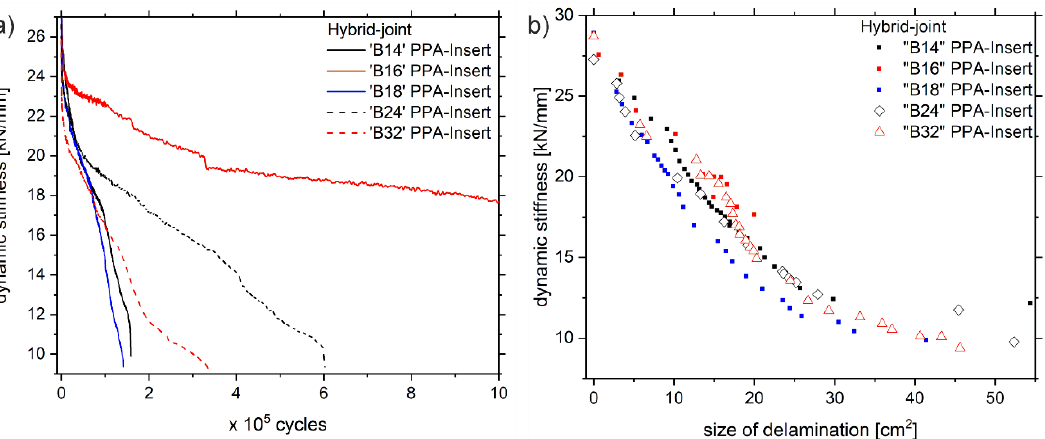
Figure 5. ( a ) Evolution of dynamic stiffness during fatigue loading with respect to loading cycles, ( b ) evolution of dynamic stiffness with respect to measured size of delamination.